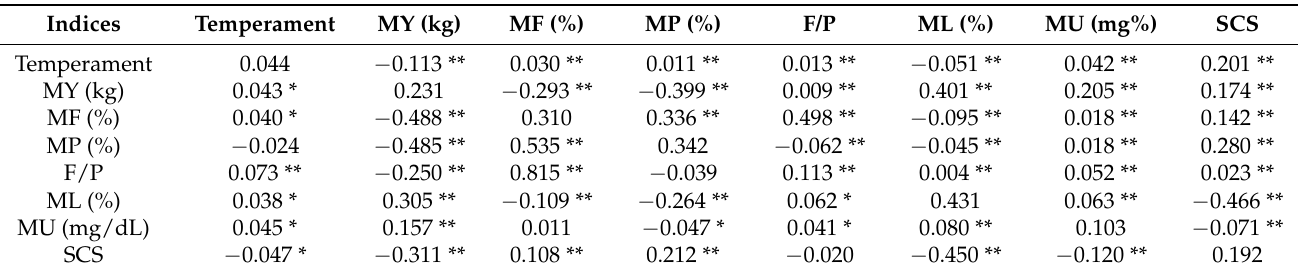
Table 1. Phenotypic (below the diagonal) and genetic (above the diagonal) correlations of cow temperament with milk indices and their heritability